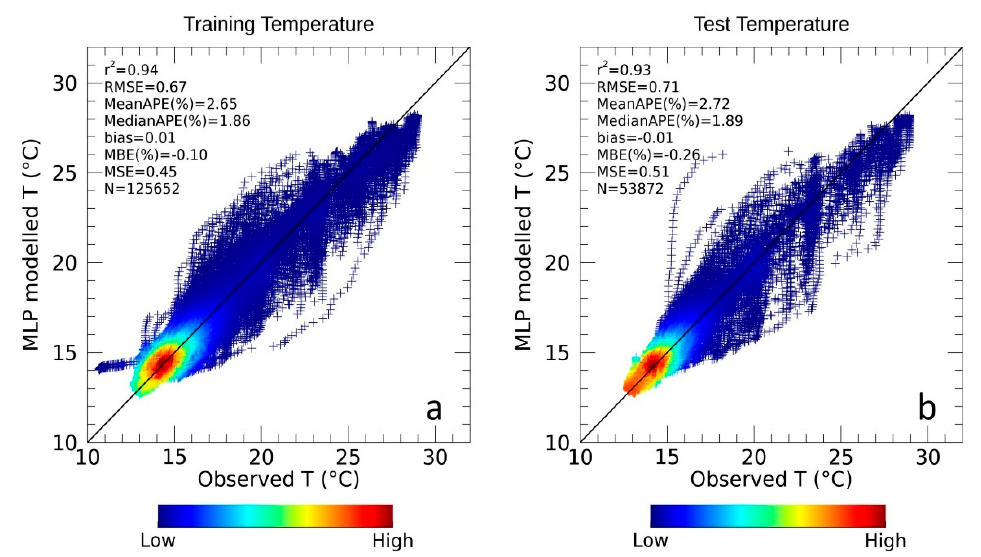
Figure 6. Training ( a ) and test ( b ) results for the MLP temperature predictions. The density scatterplot shows the observed (on x-axis) vs. the MLP predicted values (on y-axis) and their respective statistics. In black, the 1:1 bisector.